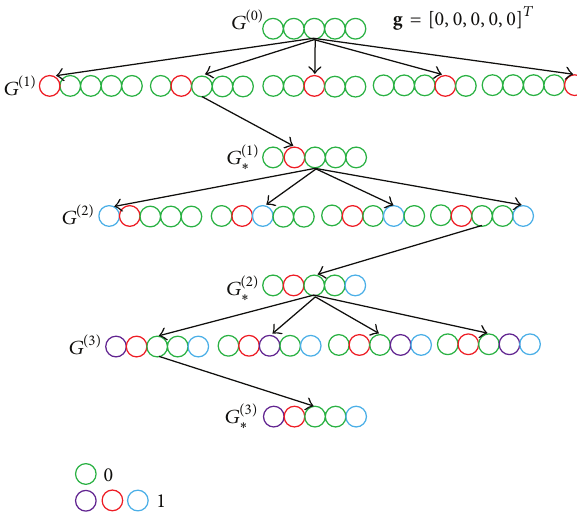
Figure 4: An intuitive example of position set selection on dom- inant channel taps, where the green circle denotes zero while the other colored circles denote one.